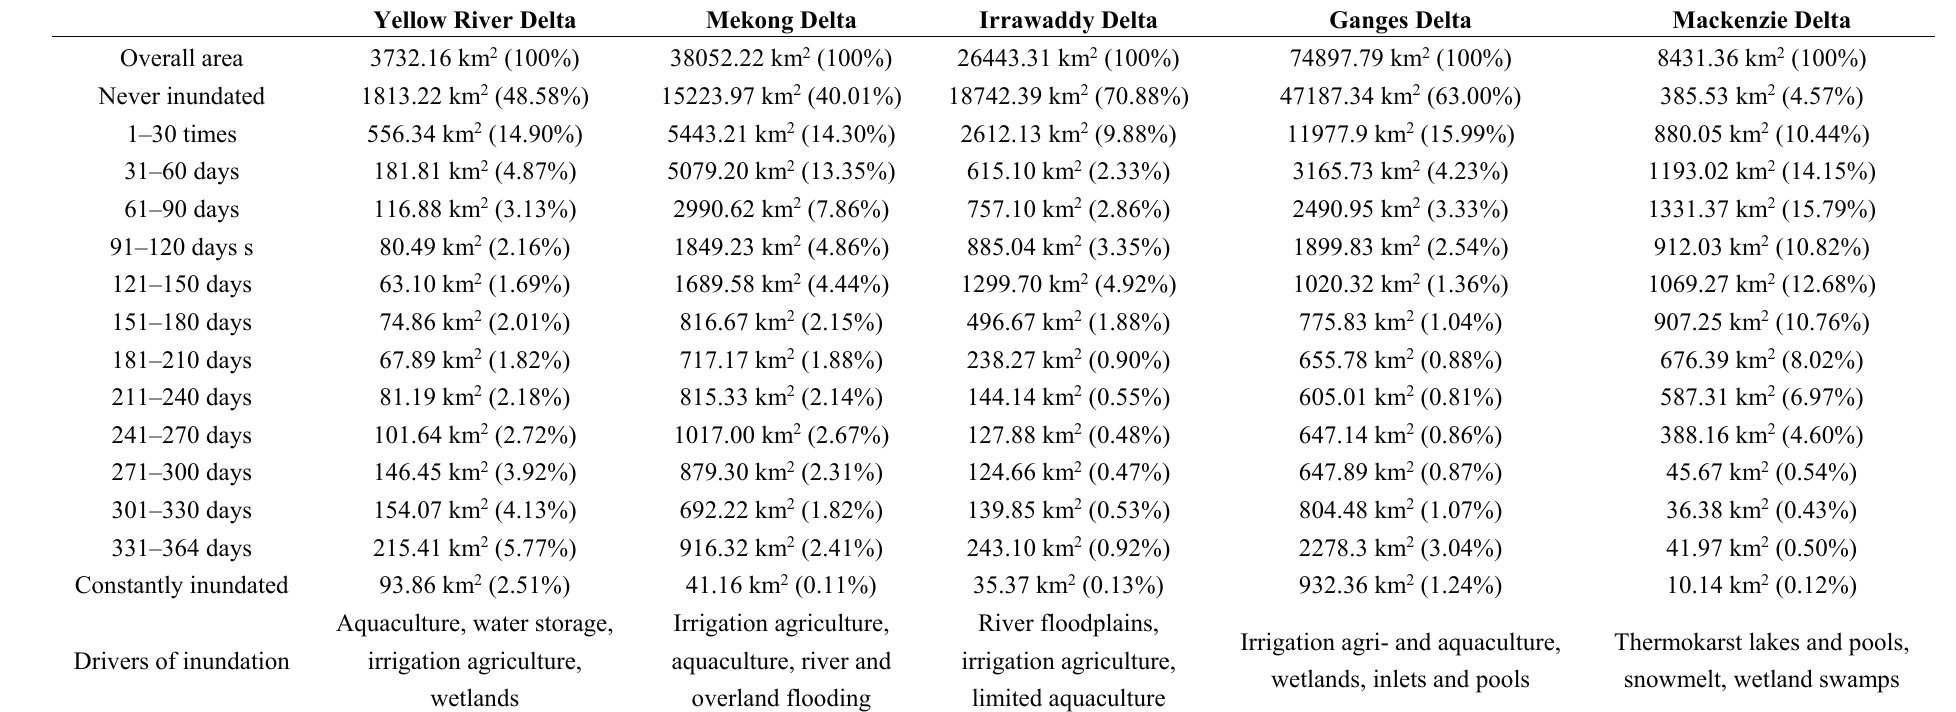
Table 2. Inundation patterns of the year 2013, for the five selected river